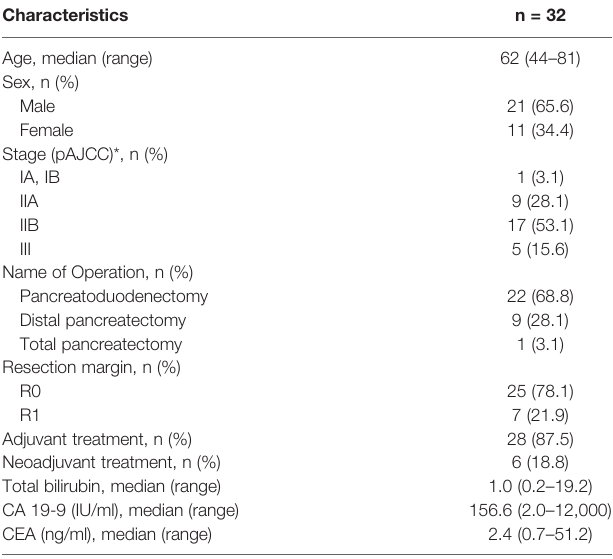
TABLE 1 | Patient characteristics (n =